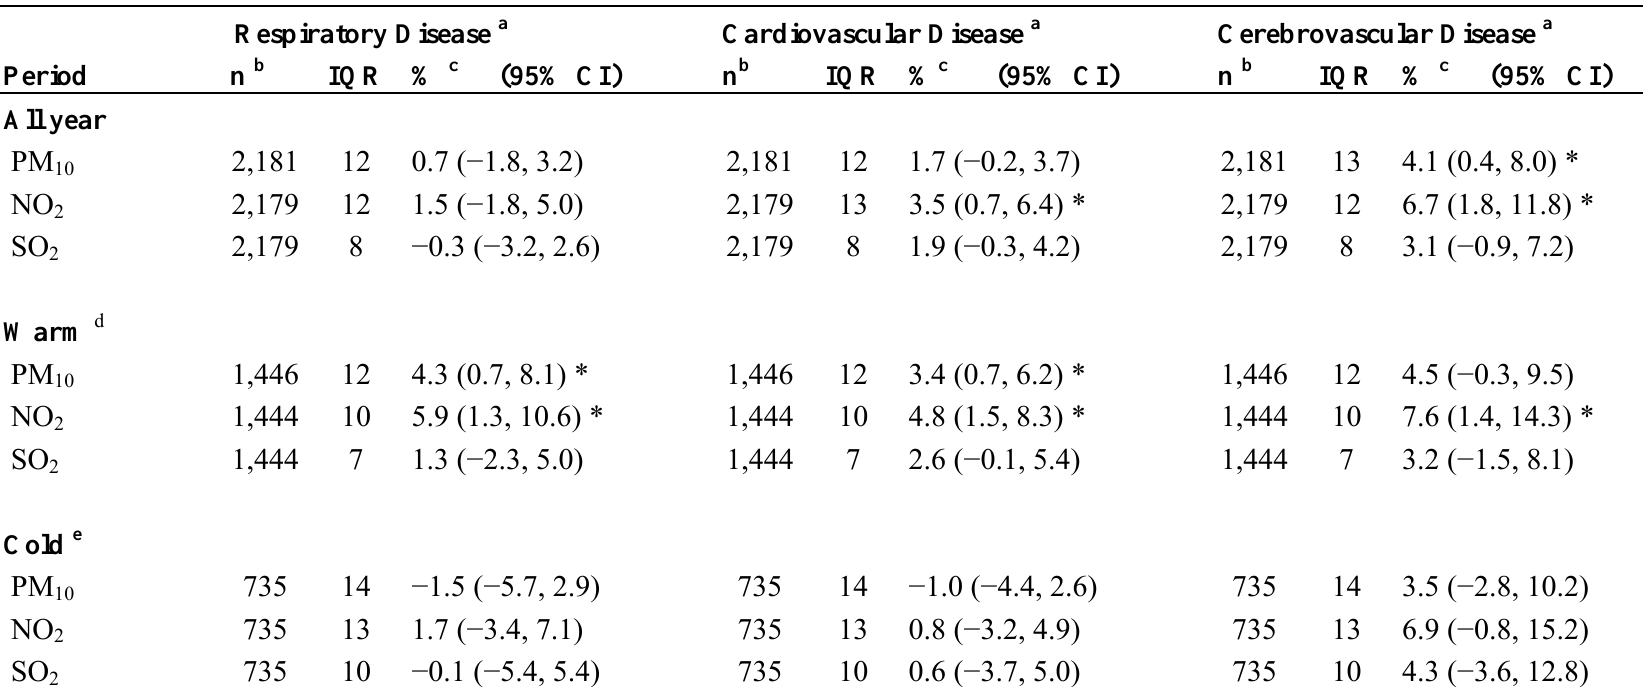
, NO and SO , and cause-specific mortality. 10 2 2